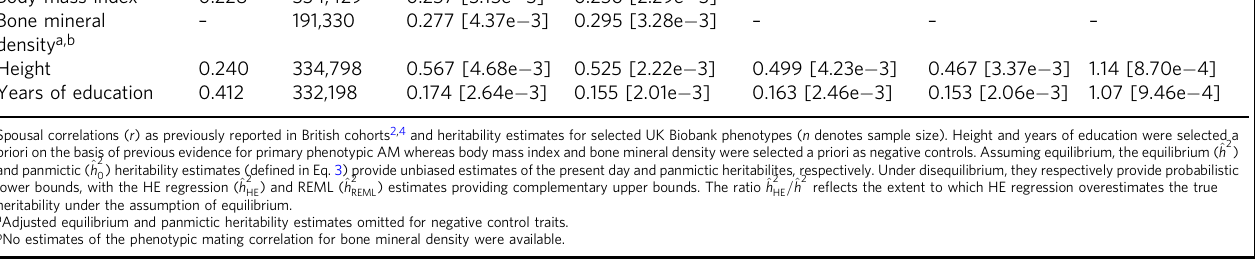
Fig. 4 REML and HE estimates across varying sample sizes in UK Biobank data. Comparison of HE ( ^ h 2 function of sample size for real traits in a sample of unrelated European ancestry UK Biobank participants. Points connected by thin lines represent estimates derived from pairs of non-overlapping subsamples of size 16,000 and n − 16,000, whereas thick lines re fl ect average log-linear trends. Two traits with previous evidence for AM (height and years of education) and two negative control traits (body mass index and bone mineral density) were selected for analysis a priori. Consistent with theoretical predictions, height and years of education demonstrated signi fi cant estimator divergence with increasing sample size whereas body mass index and bone mineral density did not.